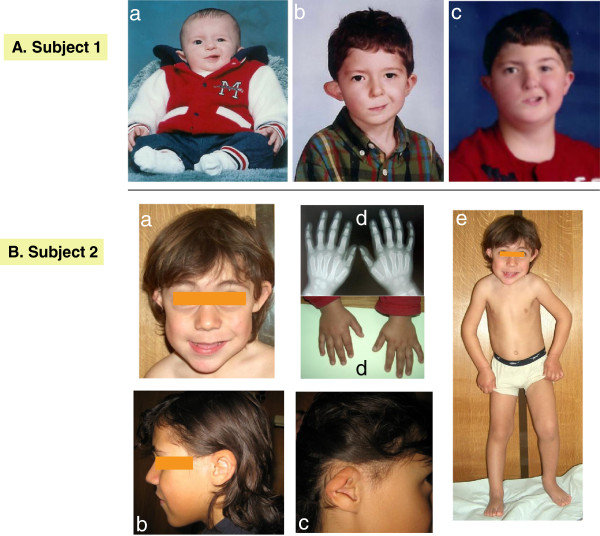
Clinical presentation of Subject 1 and Subject 2. A. Subject 1 at age 2, 7, and 13 (a-c), demonstrating the facial appearance, with asymmetry, right facial nerve palsy, dysplastic and prominent ears. By age 13, the right ear was surgically corrected. B. Subject 2 demonstrating a) asymmetry of the jaw, b) left ear with thick helix, c) right ear (post surgery): small, dysplastic, cup-shaped, anteverted, and hypoplastic lobule, d) hands with slightly tapering fingers and e) normal body proportions except short neck.